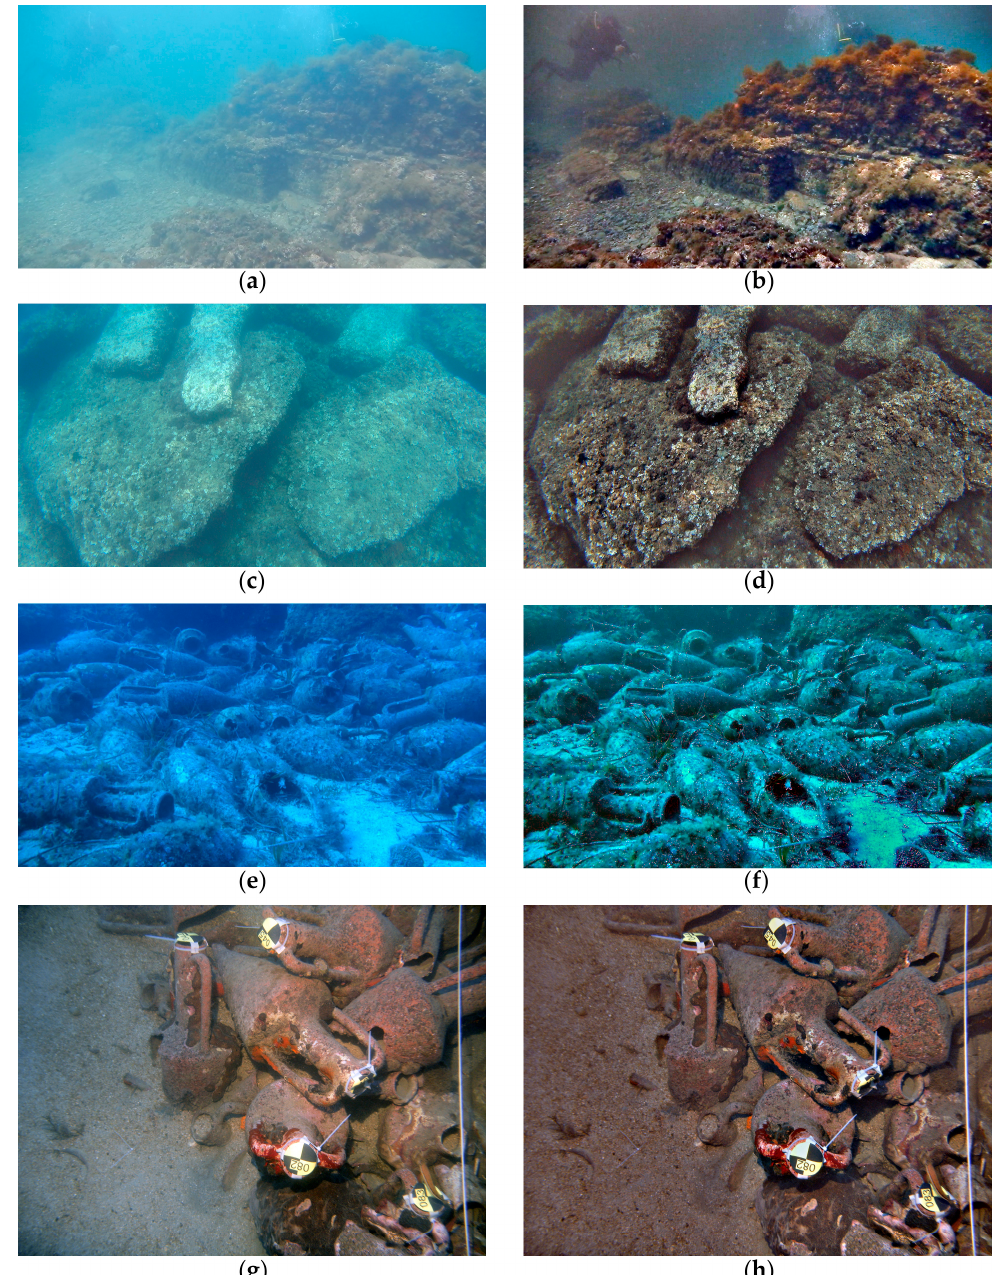
Figure 4. Sample of SP algorithm enhancement for visual evaluation. ( a , b ) “Baia2” original and enhanced images; ( c , d ) “CalaCicala3” original and enhanced images; ( e , f ) “CalaMinnola1” original and enhanced images; ( g , h ) “Mazotos1” original and enhanced images.